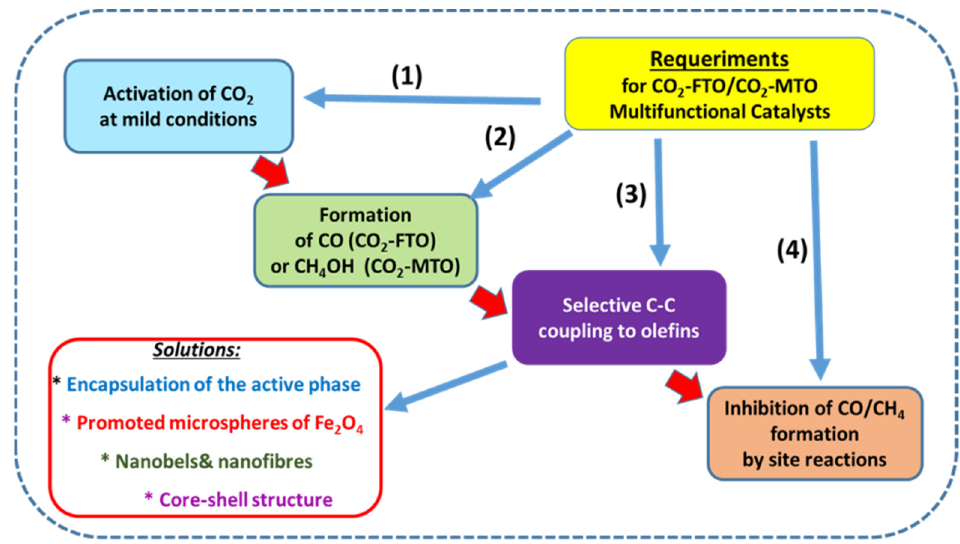
Figure 3. Visualization of the requirements for an ideal multifunctional catalyst for the production of olefins from CO 2 via the FTO and MTO routes.